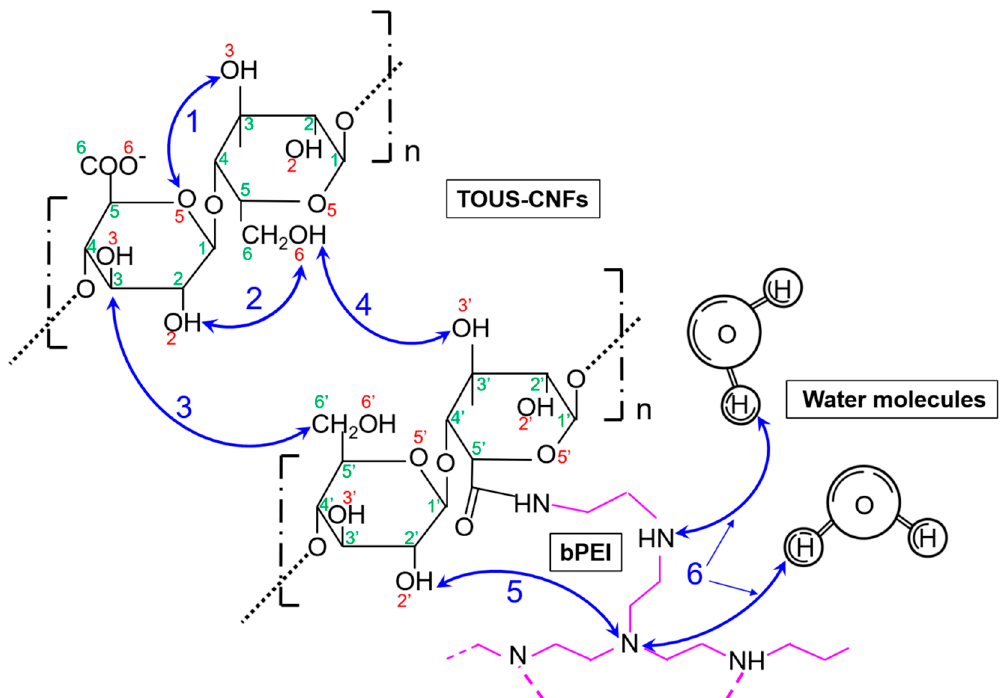
Figure 8. Schematic representation of the bPEI/TOUS-CNFs structure. Green and red numbers account for positions of carbon and oxygen atoms, respectively. Blue lines represent some of the major intra- (1 and 2, respectively associated to the O(3)H…O(5) and O(2)H…O(6)) and inter-chain (3 and 4, respectively associated to O(3)H…O(6 ′ ) and O(6)H…O(3 ′ )) hydrogen bonds occurring in the cellulosic material. In addition, HBs of type 5 and 6 account for physical cross-links between primary/secondary amines of bPEI and H atoms belonging to CNFs or adsorbed water molecules, respectively.